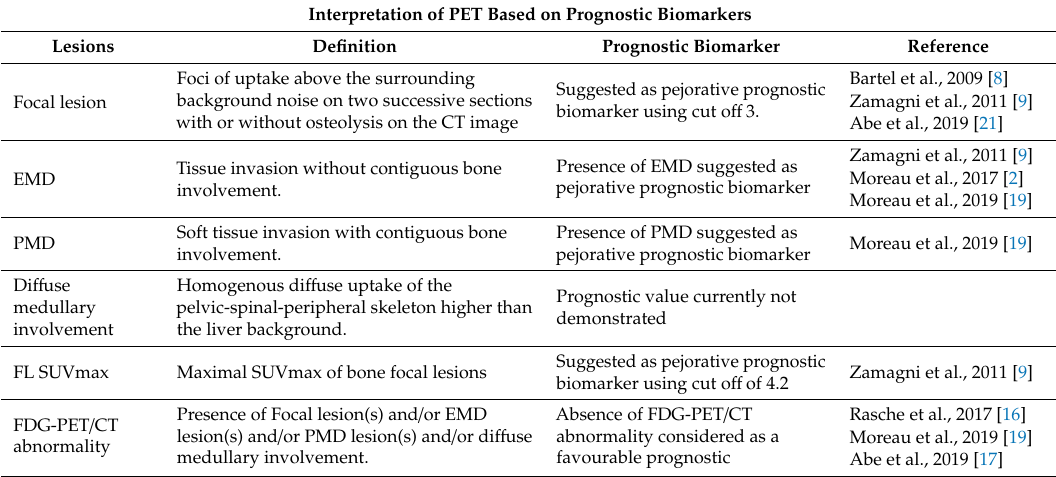
Table 1. Definition and prognosis value of FDG-PET / CT parameters in symptomatic